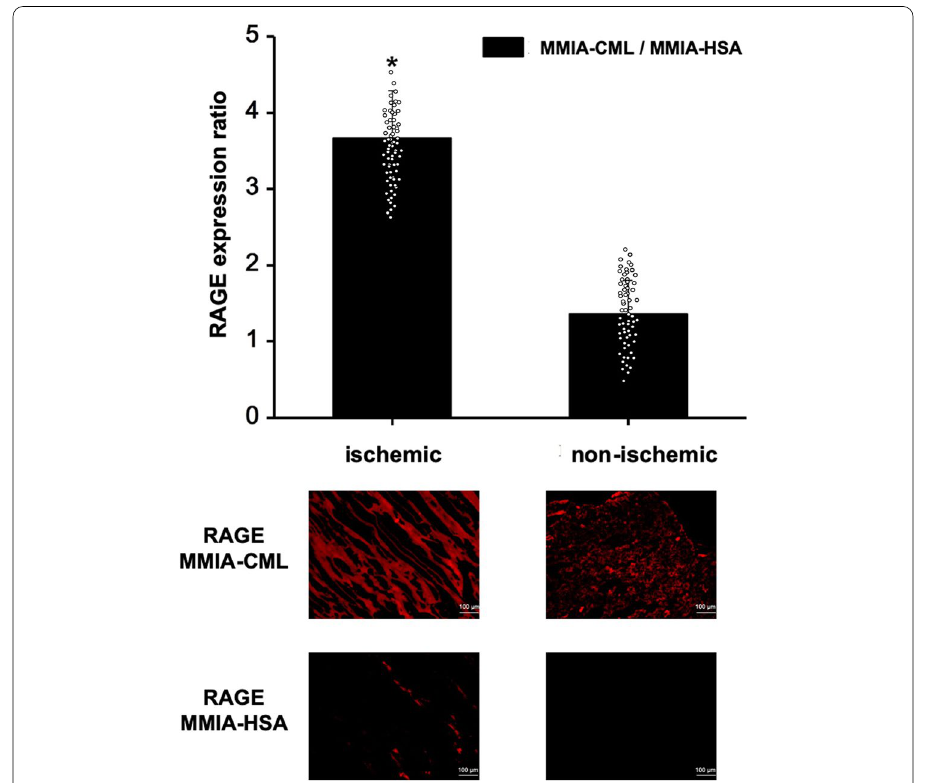
Fig. 4 Binding studies using RAGE-targeted (MMIA-CML) and non-targeted (MMIA-HSA) nanoparticles. Murine muscle tissue sections from ischemic and non-ischemic hindlimbs at 1 week after HLi were incubated with 1 µM MMIA-CML or MMIA-HSA. Quantitative measurement proved that ischemic muscle tissue fragments one week after surgical ligation of the femoral artery showed explicit RAGE-targeted probe uptake versus non-ischemic dissected tissue fragments. (*) - p < 0.05. Data represent mean and mean squared